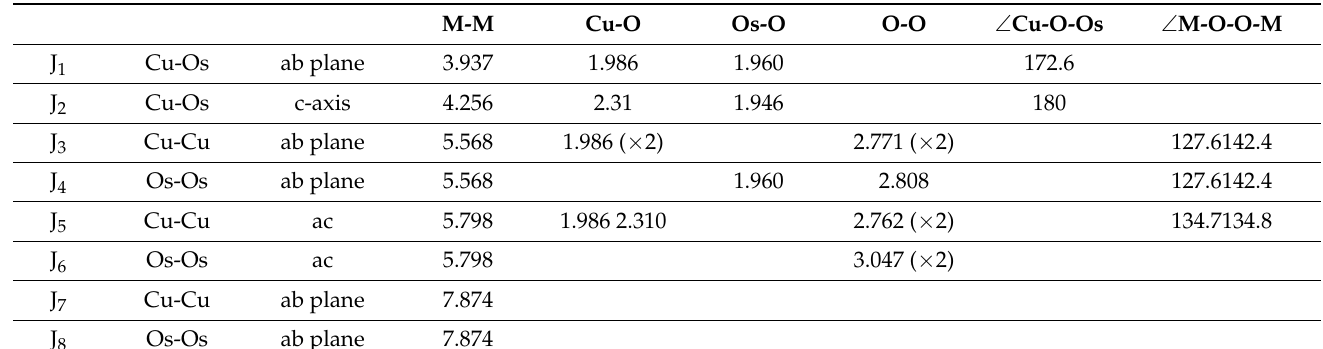
Table 1. Geometrical parameters associated with the exchange paths J 1 –J 8 in Ba 2 CuOsO 6 ;